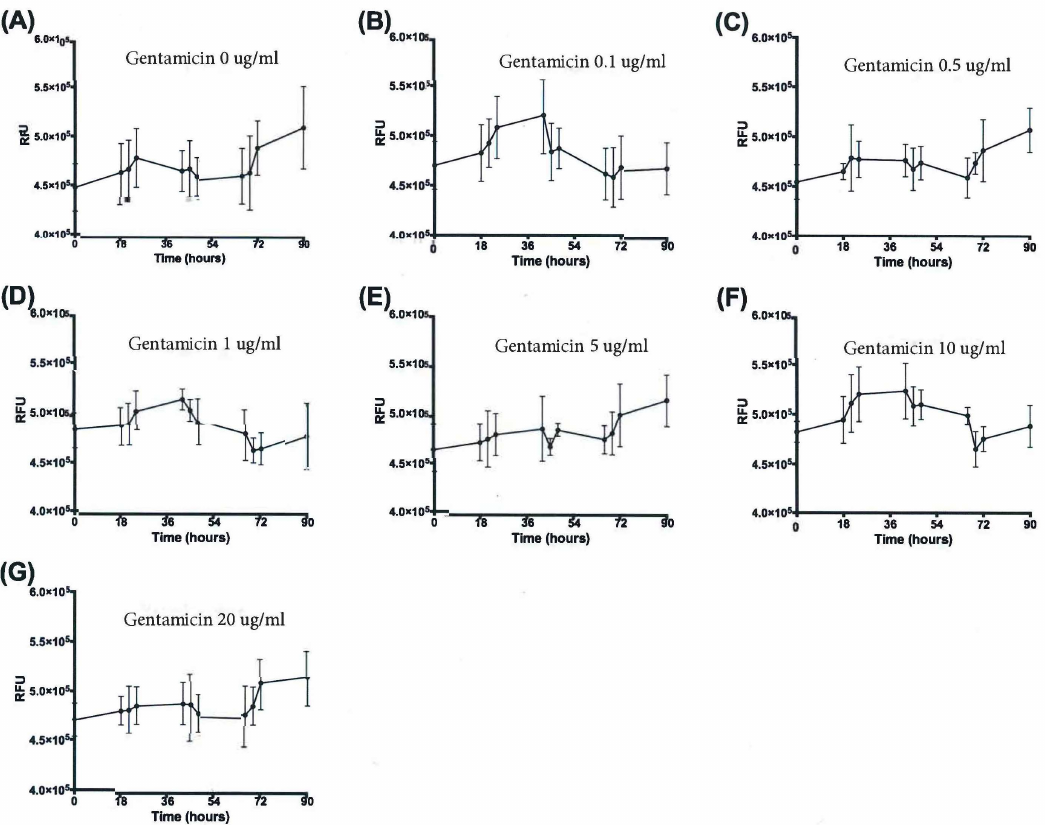
Figure 10. Cellular metabolic activity of M. avium with gentamicin treatment over 90 h. ( A ) 0 µg/mL gentamicin. ( B ) 0.1 µg/mL gentamicin. ( C ) 0.5 µg/mL gentamicin. ( D ) 1 µg/mL gentamicin. ( E ) 5 µg/mL gentamicin. ( F ) 10 µg/mL gentamicin. ( G ) 20 µg/mL gentamicin. Differences between the slopes of each treatment are significant at p < 0.001 according to linear regression analysis, n = 3.